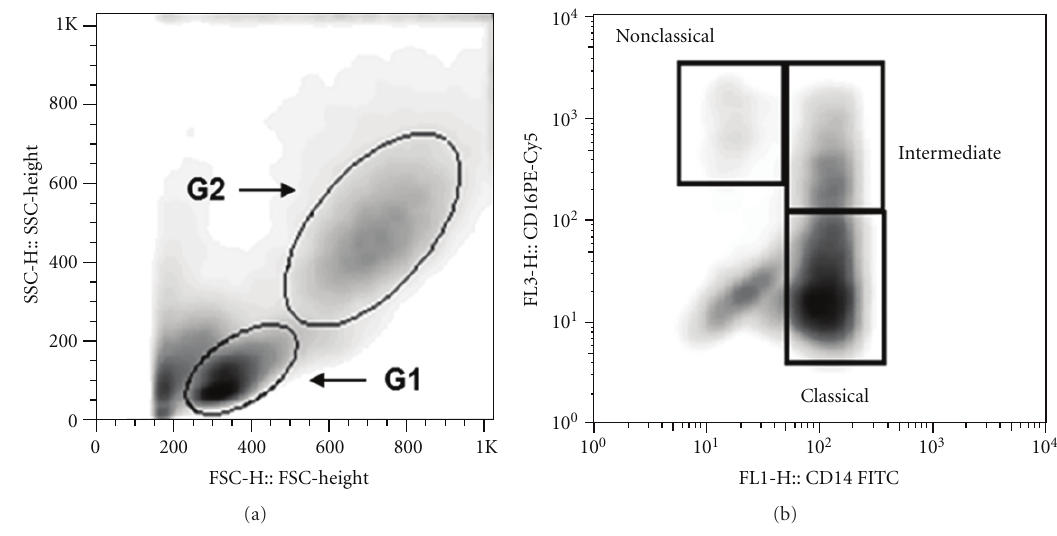
Figure 1: Strategy for T cell and monocytes evaluation by flow cytometry. The cell populations were defined by nonspecific fluorescence from the forward (FSC) and side scatter (SSC) as parameters of cell size and granularity, respectively. Lymphocytes region was determined using SSC × FSC plot (G1) and monocytes region (G2) were selected based on their granularity and expression of CD14 (a). (b) represents the strategy for monocytes subsets classification through the expression of CD14 and CD16. Representative graph of one experiment.